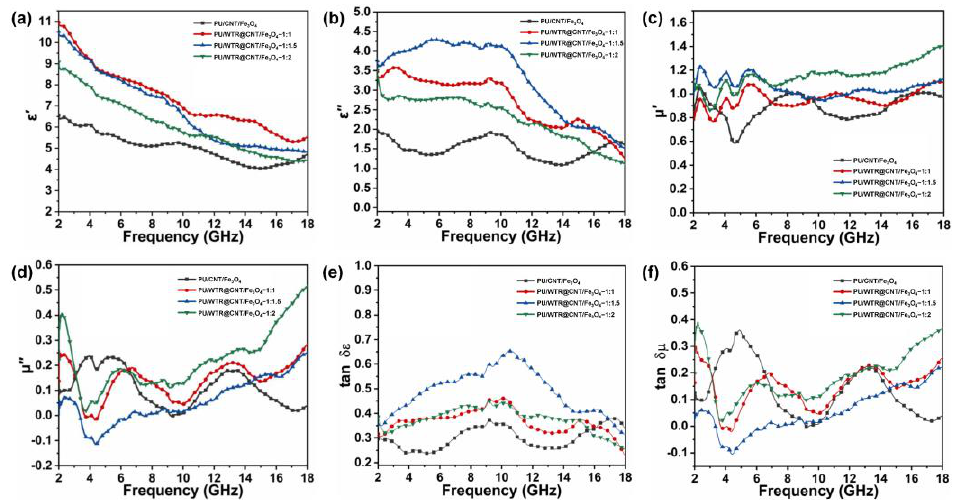
Figure 6. The ( a ) ε′, ( b ) ε″ , ( c ) μ′, ( d ) μ″ , ( e ) tan δε, and ( f ) tan δμ of the PU/CNT/ Fe 3 O 4 and PU/WTR@CNT/Fe 3 O 4 composite foams at different frequencies.